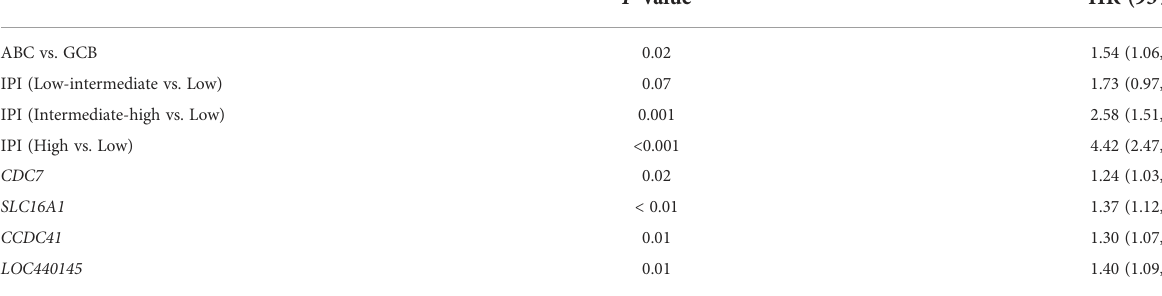
TABLE 5 Multi-variable Cox regression analyses of key genes in